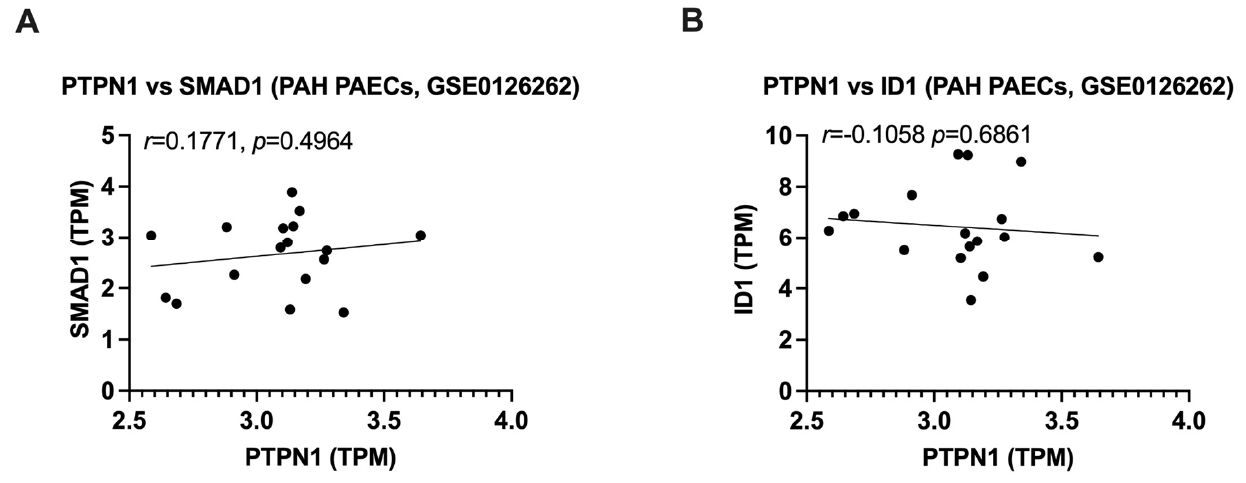
Figure 5. Correlation of PTPN1 expression with SMAD1 and ID1 in PAECs collected from healthy and PAH patients (GSE0126262). PTPN1 expression was not significantly correlated with SMAD1 ( A ) and ID1 ( B ) in the PAECs of PAH patients and healthy controls.